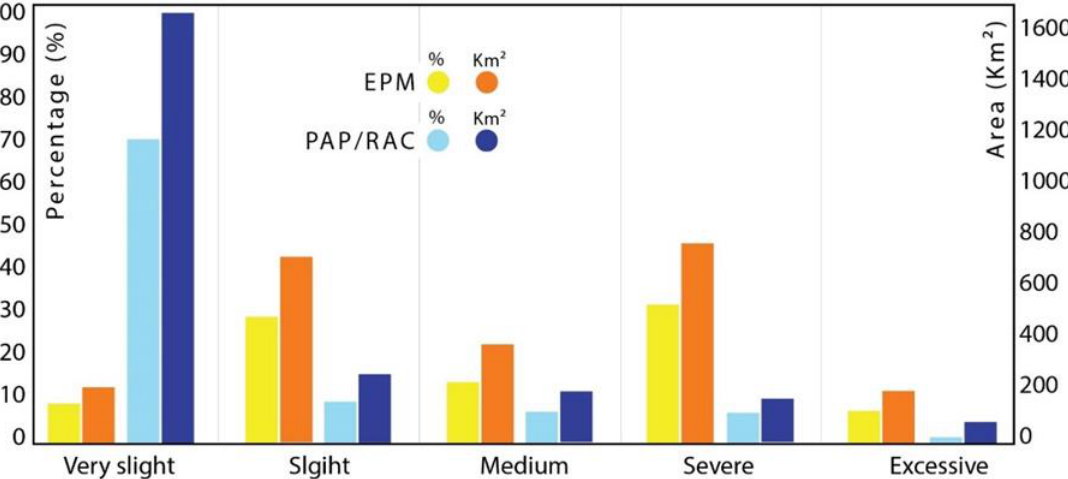
curacy of model outputs. The sensitivity of each parameter should be carefully evaluated, and modifications should be made accordingly to reduce errors and uncertainties. Addi- tionally, the applicability of the model should be assessed to ensure that it can be used in Figure 8. Evolution of impacted areas regarding the erosion degrees of both prediction models. various regions and environments [87,88].